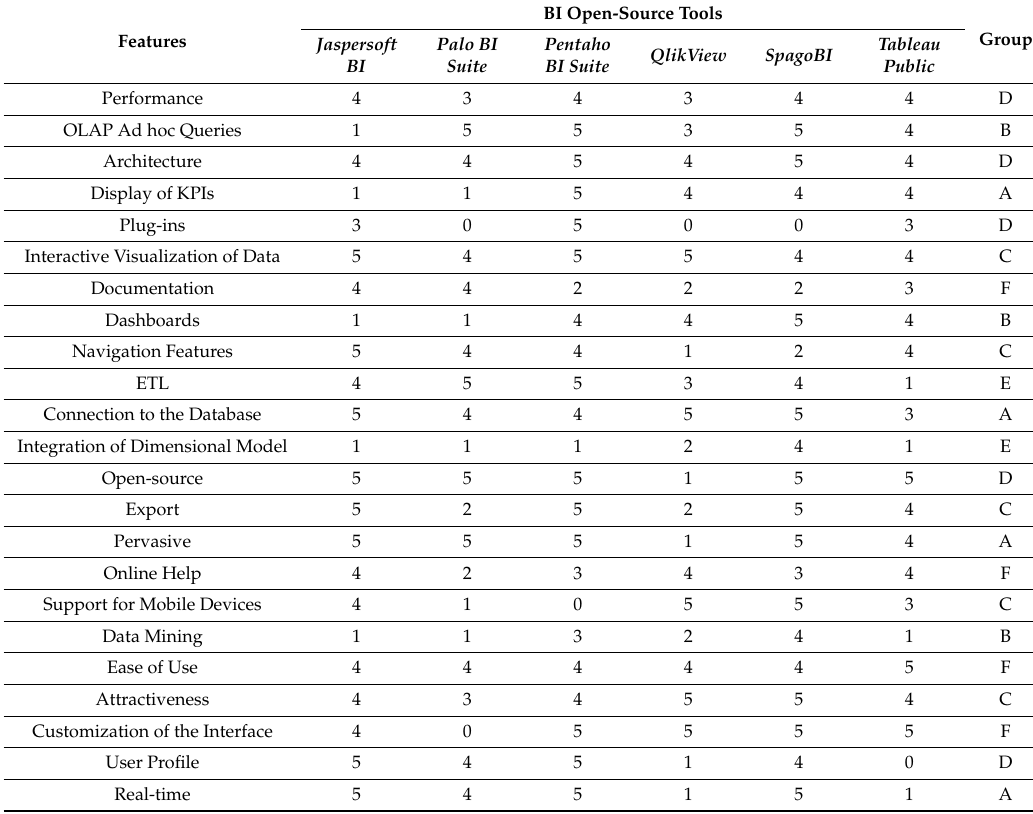
Table 1. Comparative table of the BI open-source tools selected by features and group. (0 means unknown; 1 means absent; 2 means insufficient; 3 means sufficient; 4 means good and 5 means